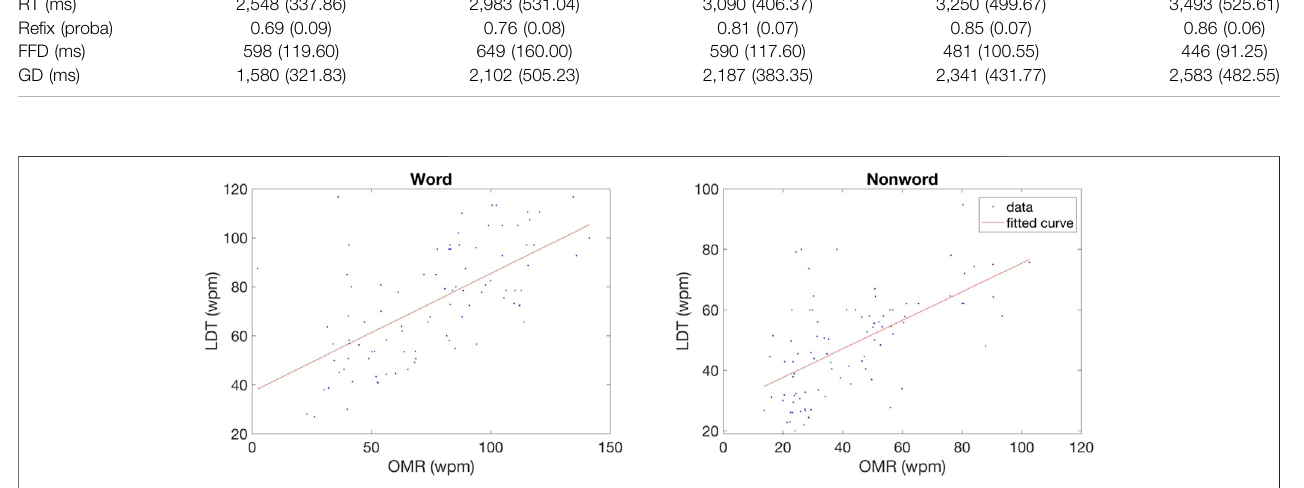
FIGURE3| ScatterplotsshowingtherelationbetweenperformanceontheOne-MinuteReadingtest(OMR)andthelexicaldecisiontask(LDT)forwords(leftpanel, R 2 (cid:2) 0.40) and pseudowords (right panel, R 2 (cid:2) 0.35). Lines are best fi tting linear regressions.